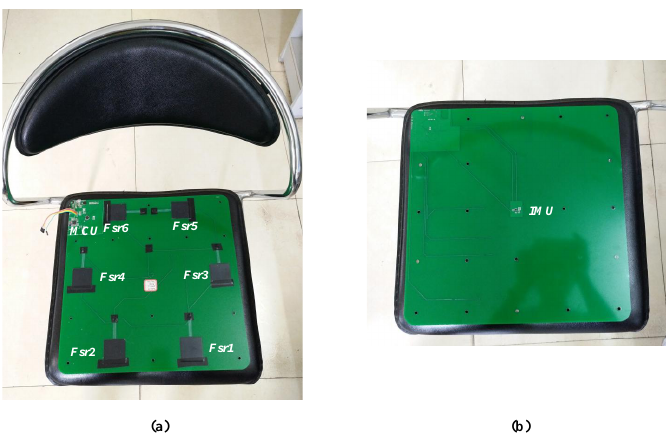
Figure 3. Deployment of the smart cushion circuit board on a real chair: ( a ) front of the circuit board; ( b ) back of the circuit board.